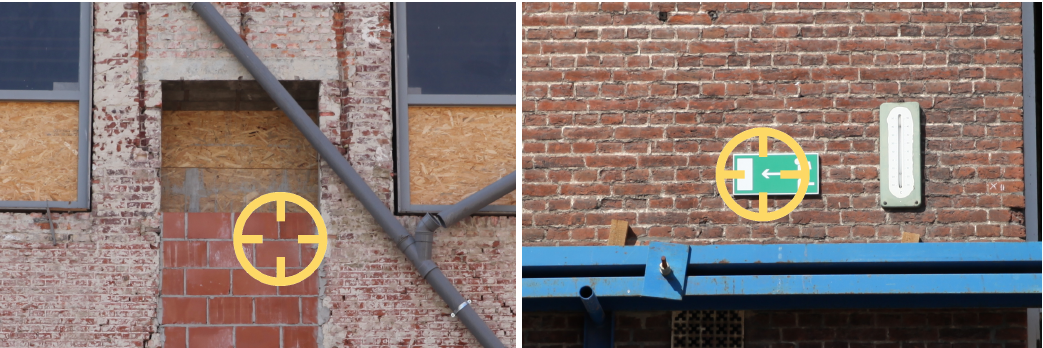
Figure 4. Two examples of Ground Control Points (GCPs). Because only distinctive features are selected as GCP, materialisation of the points has become